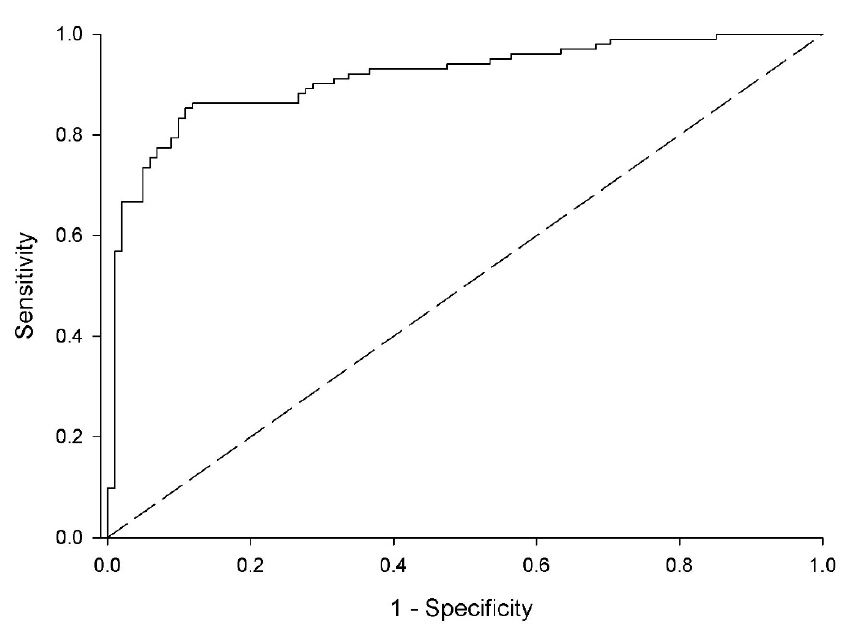
Figure 3. Receiver operating characteristic (ROC) curve of the logistic multiple regression analysis equation for determination of presence of ARC. Area under the ROC curve was 0.914 (95% confidence interval, 0.874, 0.955). p = 0.001.